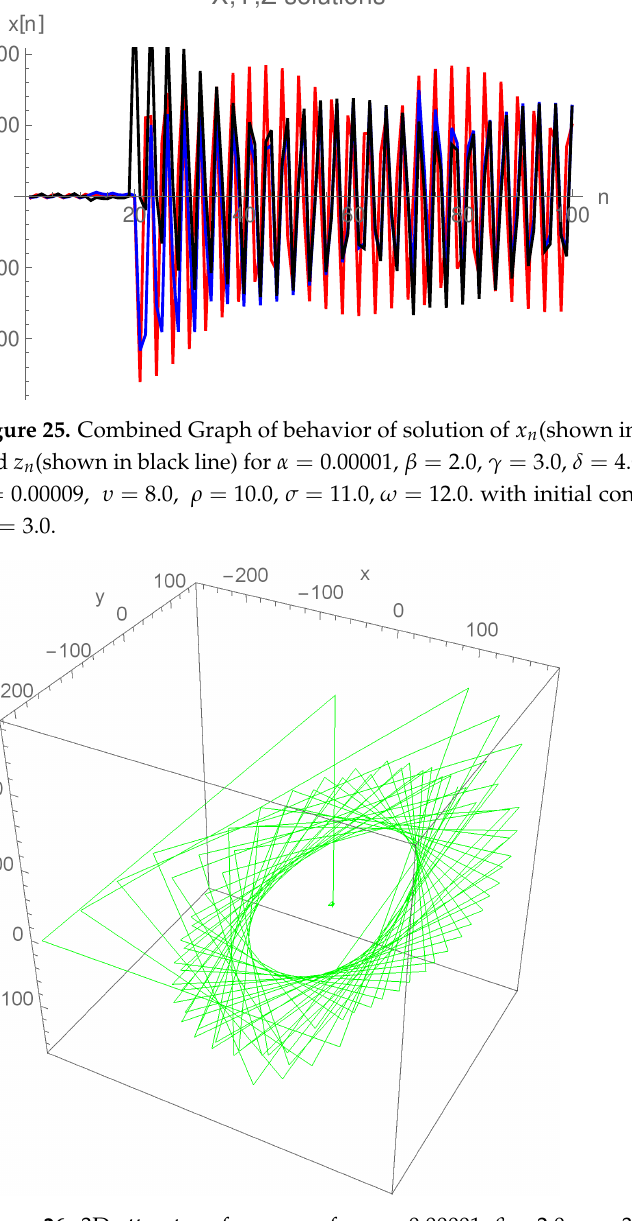
Figure 26. 3D attractor of x n , y n , z n for α = 0.00001, β = 2.0, γ = 3.0, δ = 4.0, ζ = 0.00005, η = 6.0, µ = 7.0, ε = 0.00009, υ = 8.0, ρ = 10.0, σ = 11.0, ω = 12.0. with initial conditions x 0 = 1.0, y 0 = 2.0 and z 0 =